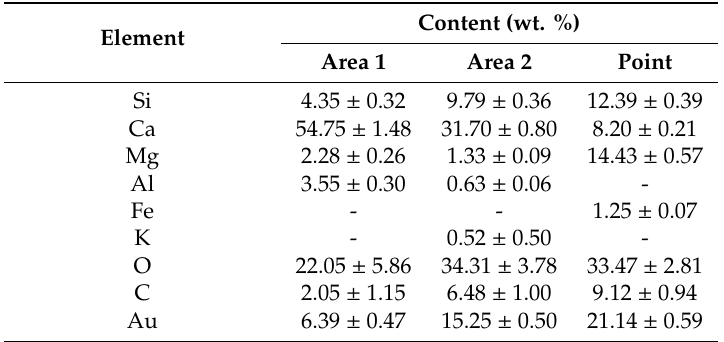
Table 3. Elemental analysis of the whole area of asbestos–cement sample (Area 1—Figure 1c; Area Area 2—Figure 1e) and at a selected point (Figure 2—Figure 1e) and at a selected point (Figure 1a).